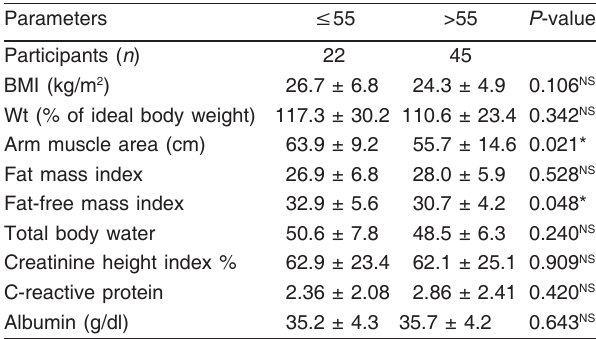
Table 5 Anthropometric parameters as regards age in the chronic obstructive pulmonary disease group